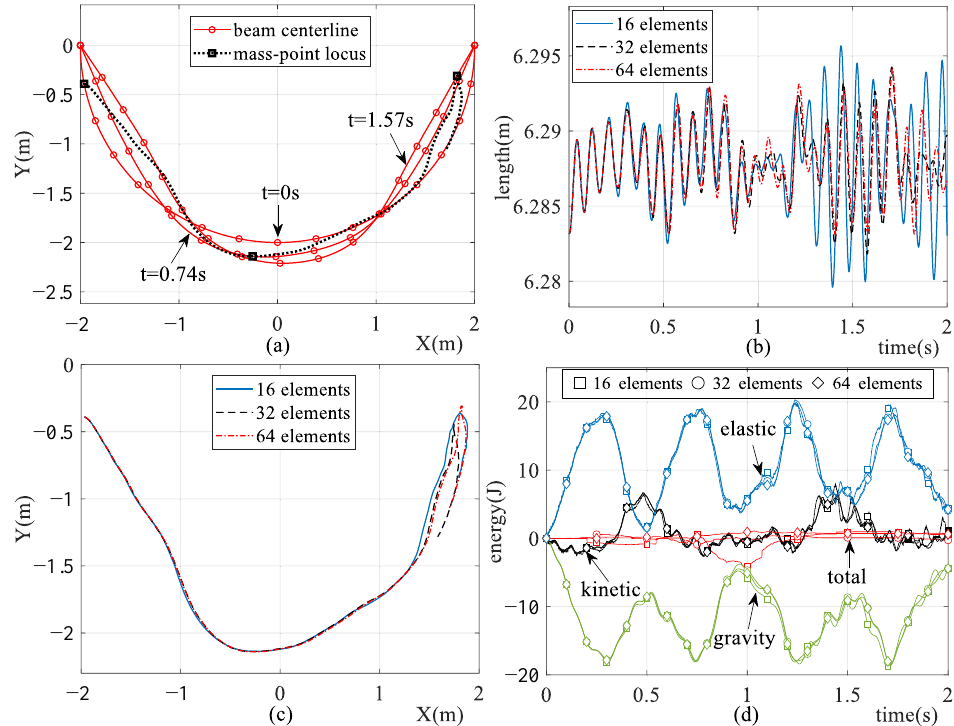
Figure 16. Simulation results of dynamic model, including ( a ) model configurations, ( b ) length of the beam, ( c ) trajectory of the sliding node, and ( d ) system